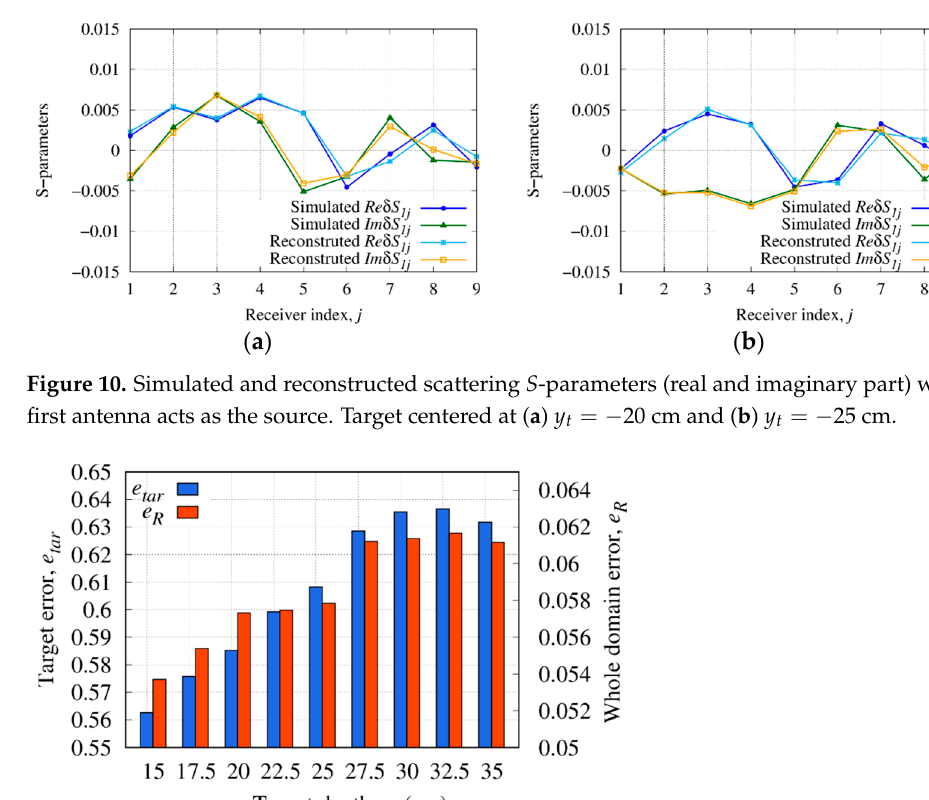
Figure 10. Simulated and reconstructed scattering S-parameters (real and imaginary part) when